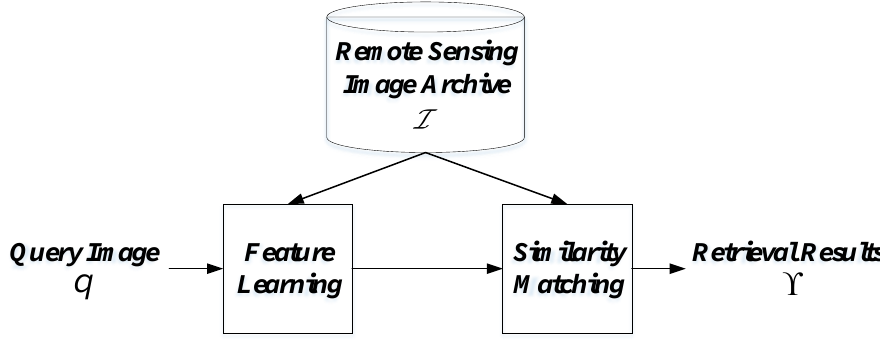
Figure 1. Framework of basic remote sensing image